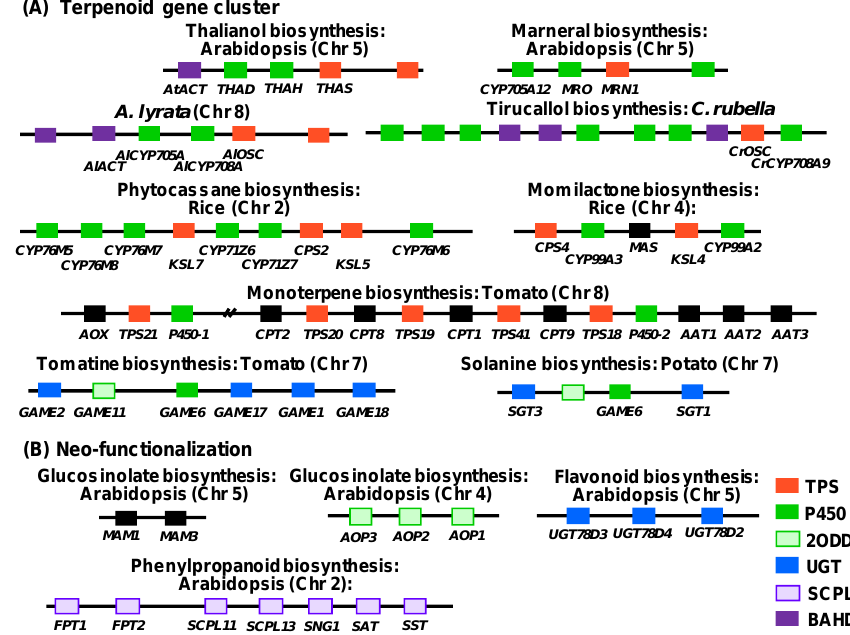
Figure 1. Neighboring genes of plant secondary metabolism. ( A ) Reported terpenoid gene cluster in plants. ( B ) Genomic neo-functionalization in plant secondary metabolism. Abbreviations: ACT, acyltransferase; THAH, thalianol hydroxylase; THAS, thalianol synthase; MRO, putative marneral oxidase; MRN, marneral synthase; baruol synthase, BARS1; OSC, oxidosqualene synthase; CPS, labdadienyl / copalyl synthases; KSL, kaurene synthase-like gene; MAS, momilactone A synthase; SAD, saponin-deficient; AMY, oxidosqualene cyclase; GAME, glycoalkaloid metabolism; SGT, sterol alkaloid glycosyltransferase; AOX, aldehyde oxidase; TPS, terpene synthases; CPT, cis -prenyl transferases; AAT, alcohol acyl transferases; TPS, terpene synthase; SCPL, serine carboxypeptidase-like; P450, CYP; 2ODD, 2-oxoglutarate-dependent dioxygenase; UGT, UDP-sugar dependent glycosyltransferase family.